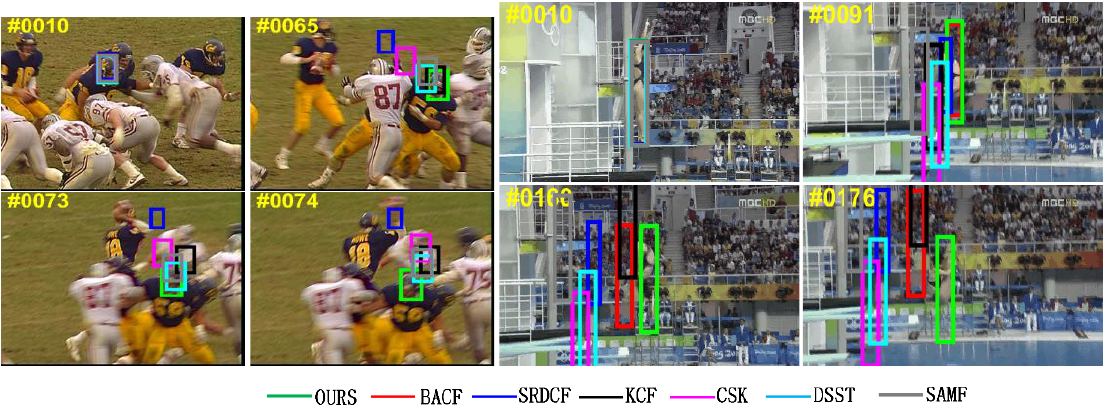
Figure 8. Tracking results of seven trackers on Football1 ( left ) and Diving ( right ).